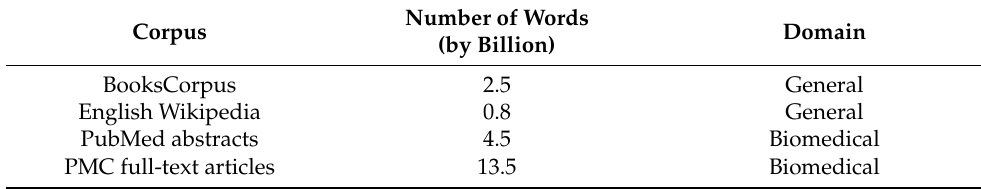
Table 1. List of pre-trained corpora for BioBERT. Corpus